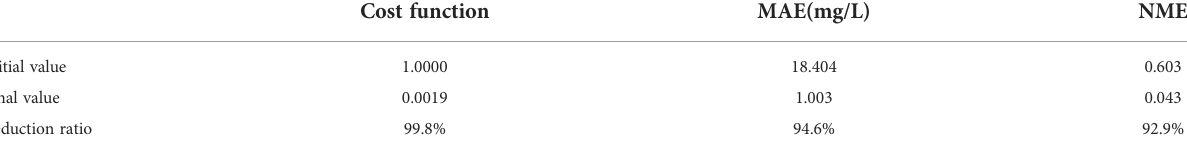
TABLE 1 The cost function, MAE and NME of Ideal Experiment